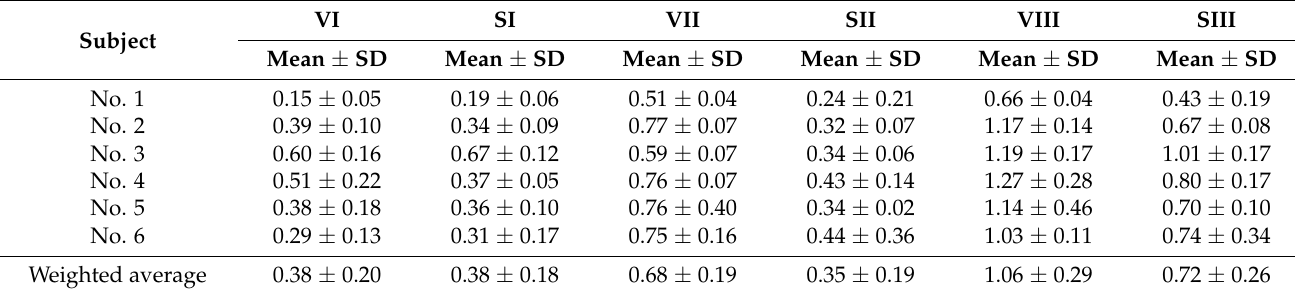
Table 2. Results of the measurements for each